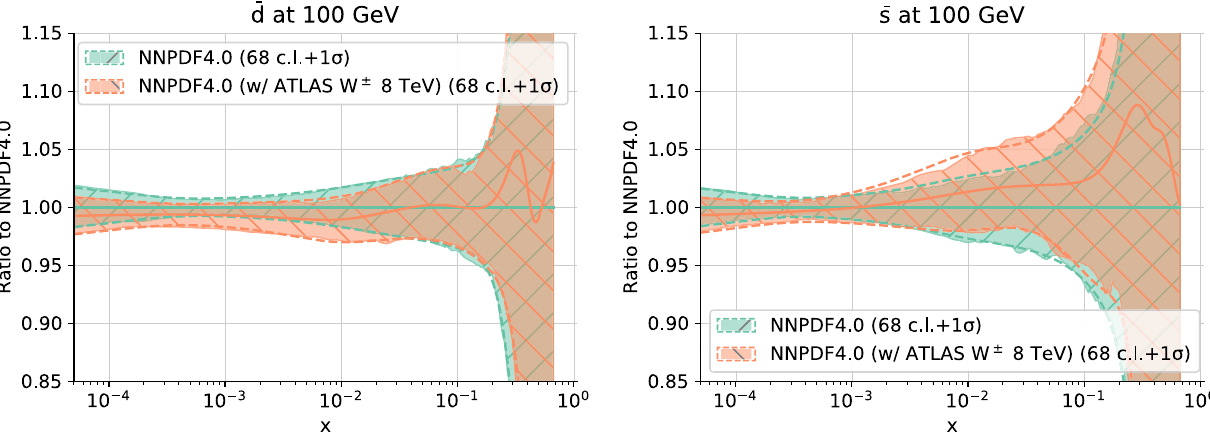
Fig. 41 Comparison to the baseline of the antidown and antistrange PDFs obtained adding to the baseline the ATLAS lepton rapidity distributions from W ± production at 8 TeV [81]